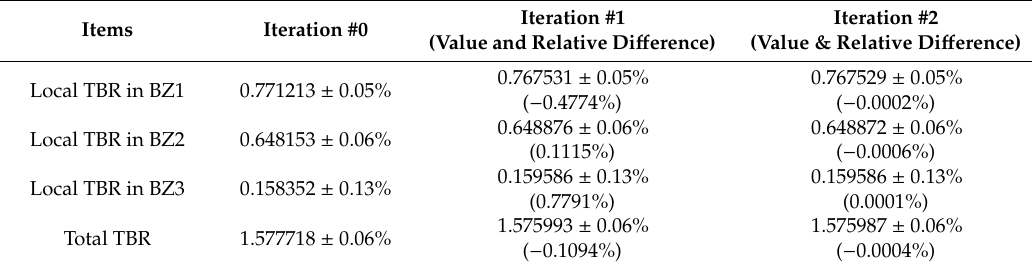
Table 10. TBR variation in the two-way N / TH coupling calculation of the HCSB